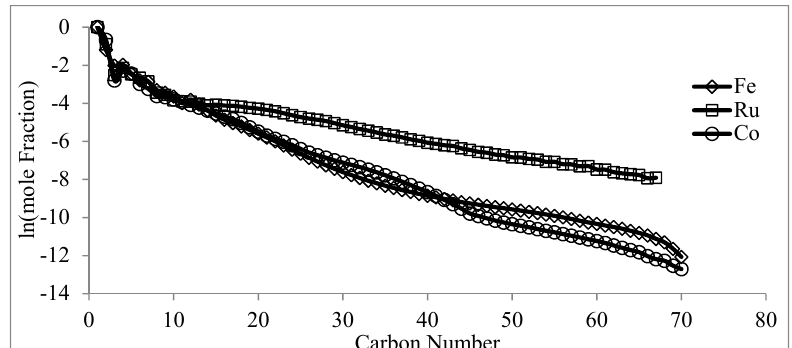
Figure 5. A proposed FTS route based on the CO insertion mechanism.